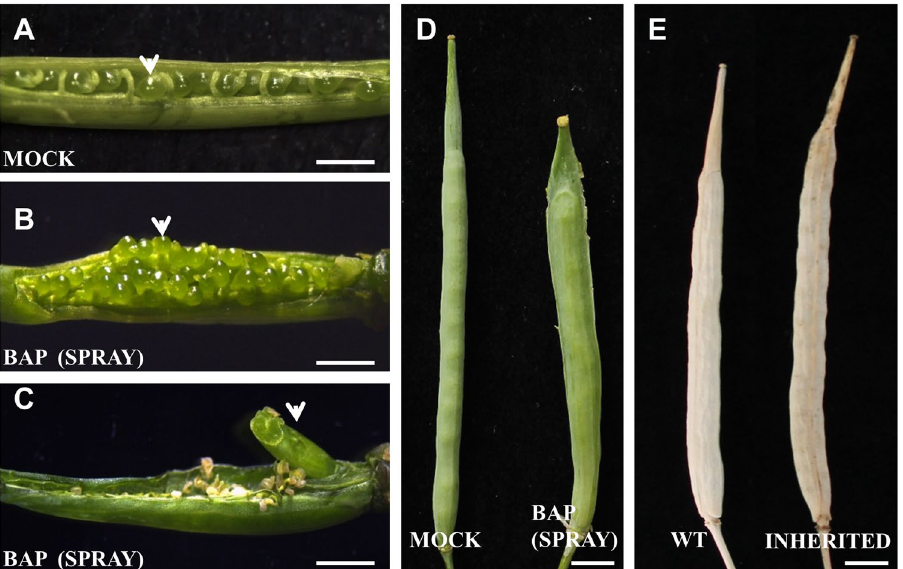
Figure 4. Phenotypes caused by exogenous BAP application in gynoecium and fruit of Brassica napus . ( A ) Mock-treated gynoecium where the ovules are shown (arrowhead). ( B ) BAP-treated gynoecium where the ovules are shown (arrowhead). ( C ) BAP-treated gynoecium where an extra carpeloid structure is shown (arrowhead). ( D ) Mock and BAP-treated green fruits that have reached their maximum size. ( E ) Mature fruit of a wild type plant and of an offspring plant that was BAP-treated showing an inherited phenotype. Scale bars: ( A – C ) 1 mm; ( D , E ) 5